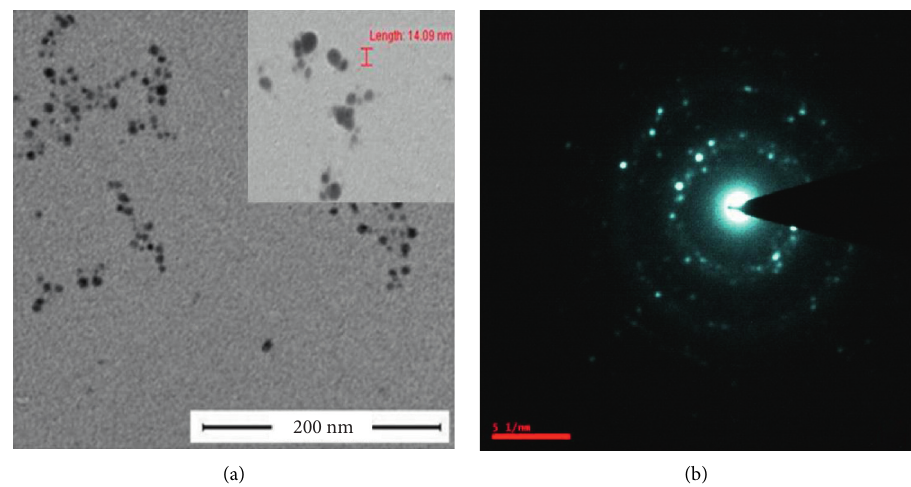
Figure 3: (a) TEM micrograph and (b) SEAD pattern of AgNPs synthesized using B. lanzan